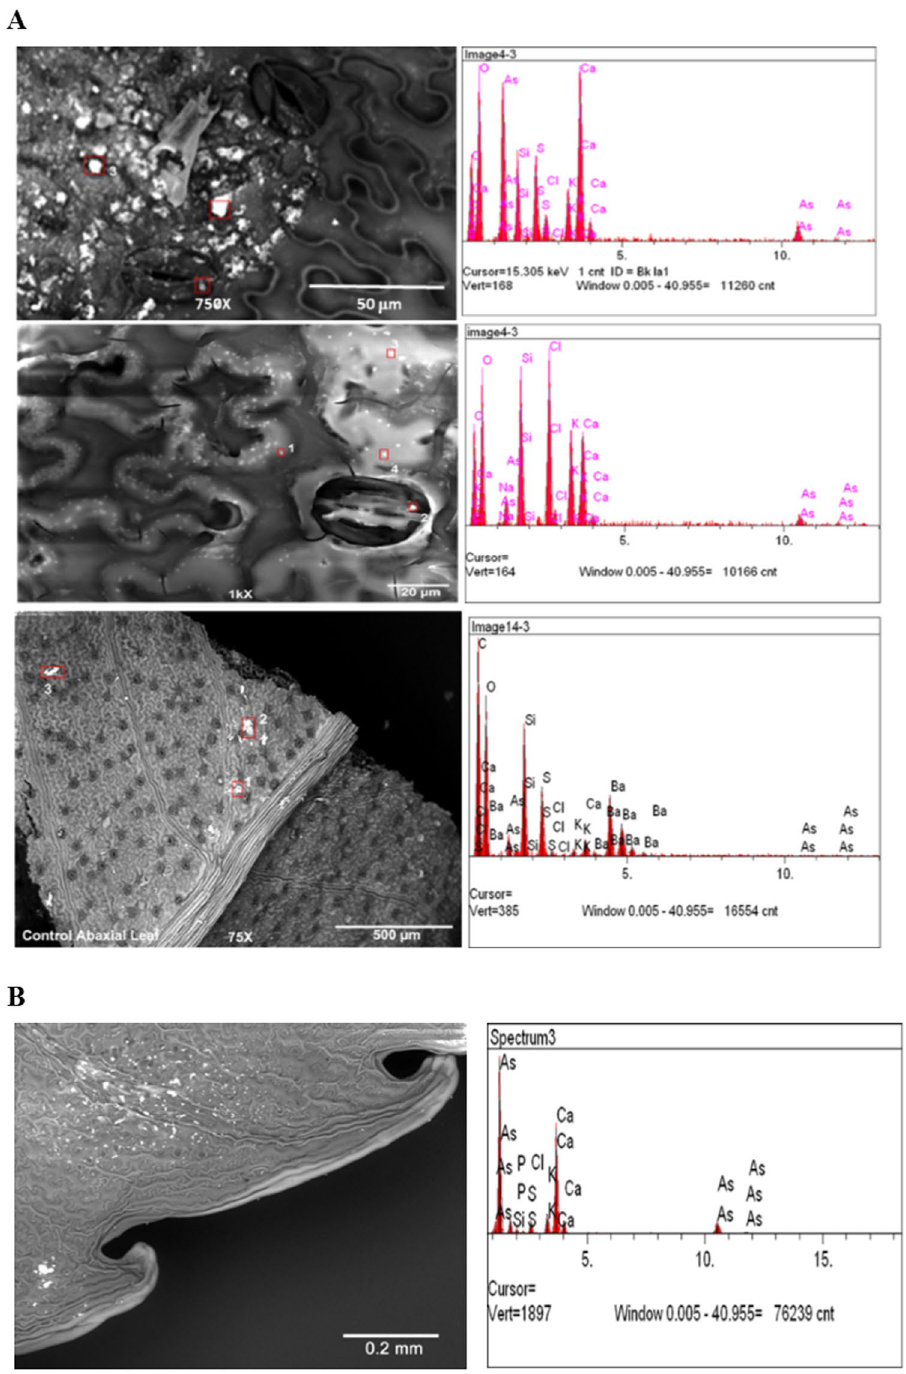
Figure 3. ( A ) SEM-EDX mapping of the abaxial surface of As (V) treated leaflet treated with 13.3 mM AsV. SEM images of PV pinnae (left) showing crystalline deposits. Multiple spots on each sample (marked by red squares) were analyzed by EDX (right). Top Panel: Arsenic-treated pinna before extraction, Middle Panel: As- treated pinna after extraction, Lower Panel: Control pinna (untreated). ( B ) SEM-EDX mapping of the adaxial surface of As (V) treated leaflet treated with 13.3 mM AsV. Spots on were analyzed by EDX